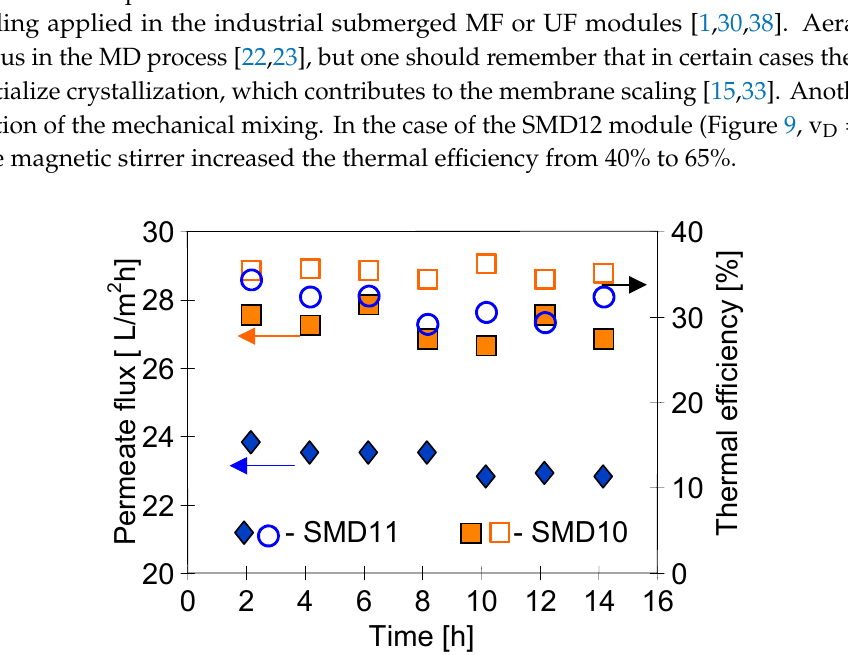
Figure 19. The influence of module construction on the permeate flux and thermal efficiency. Membrane PV370. Module design: SMD10—Figure 4E, SMD11—Figure 4B. Mode 1. T F = 353 K, v = 0.75 m/s.